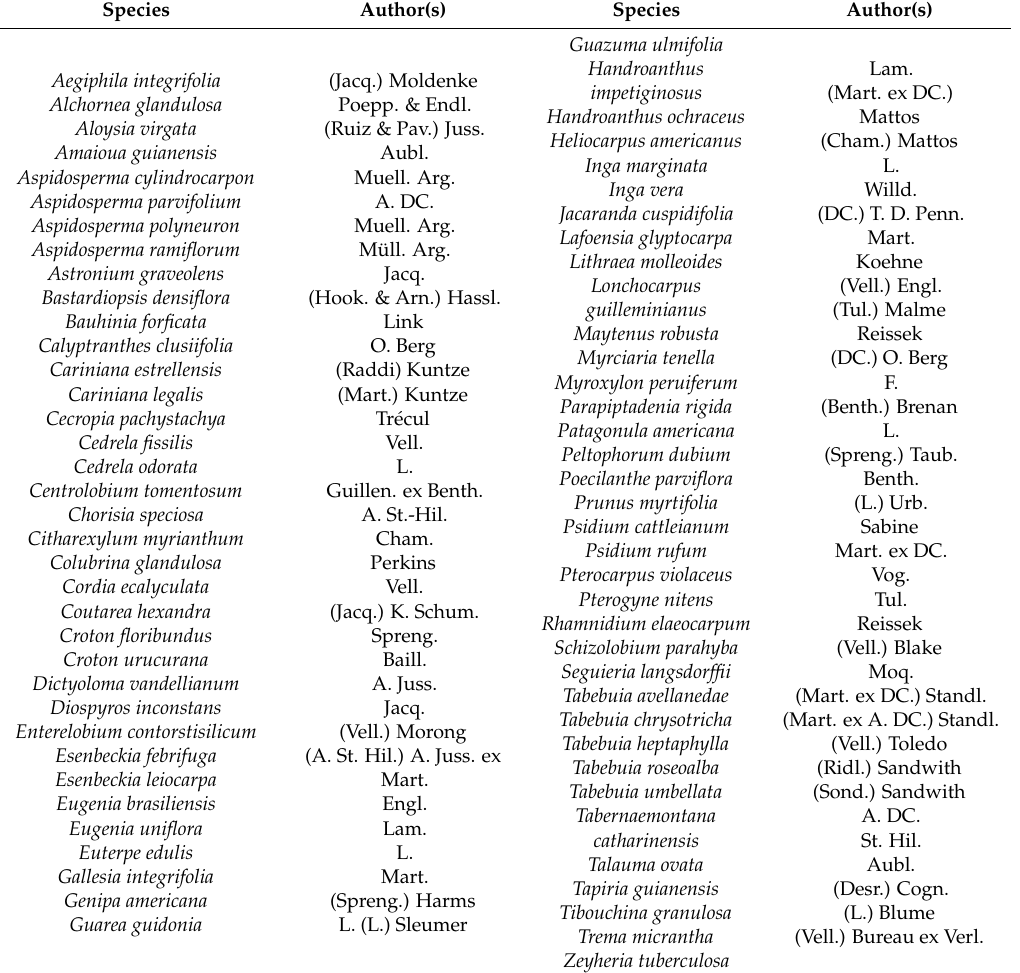
Table A1. Tree seedling species reintroduced in the restoration sites (R1–R6) of the study area.